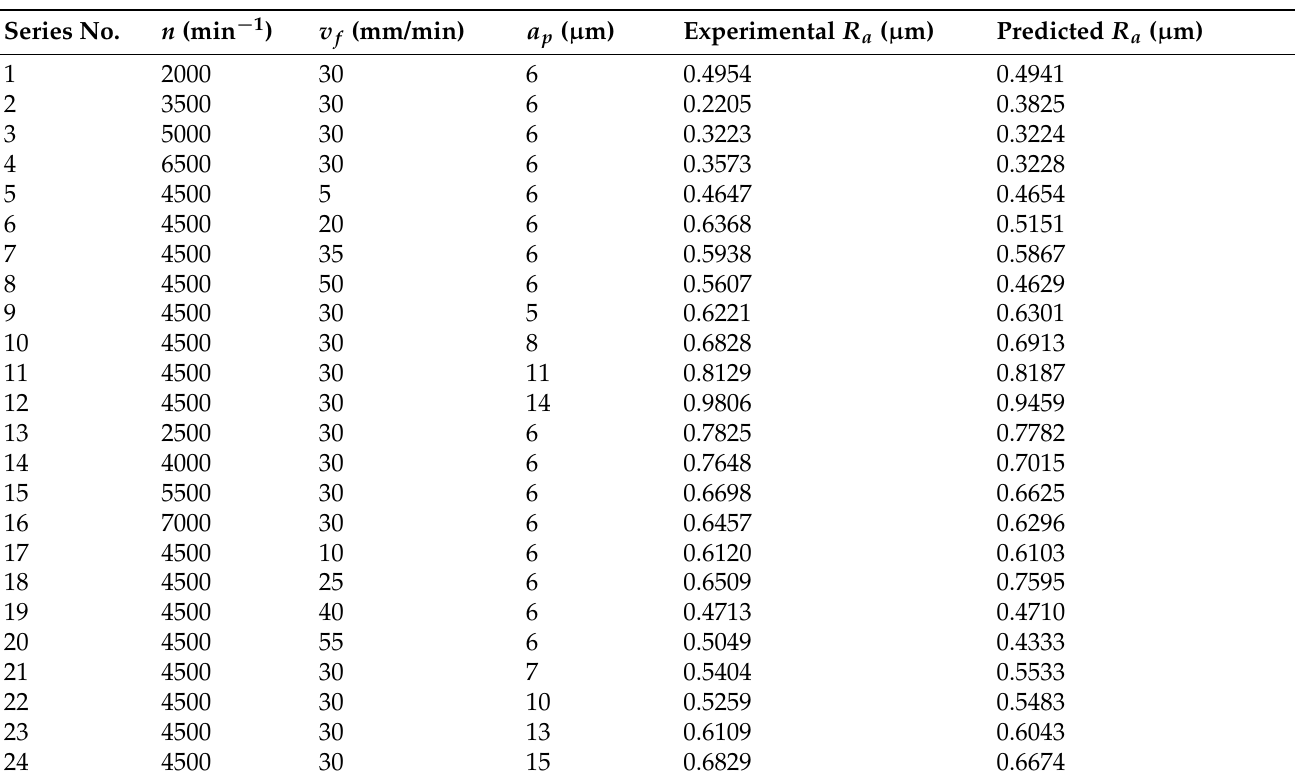
Table 3. Details of the experimental